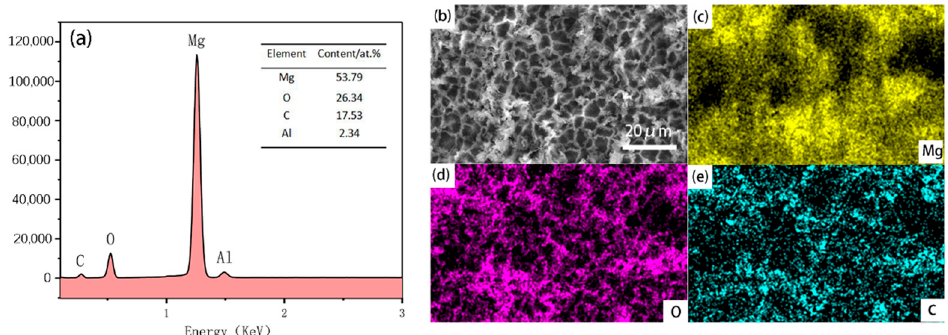
Figure 5. ( a ) Results of EDS on the SMA surface; ( b ) SEM morphology; ( c–e ) EDS elemental mapping images of the SMA surface.